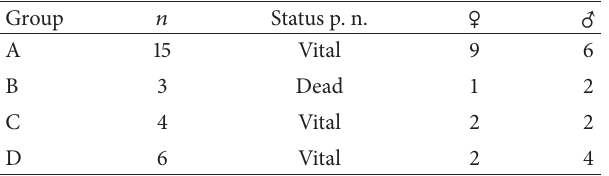
Table 1: Proband groups ( 𝑛 = 28